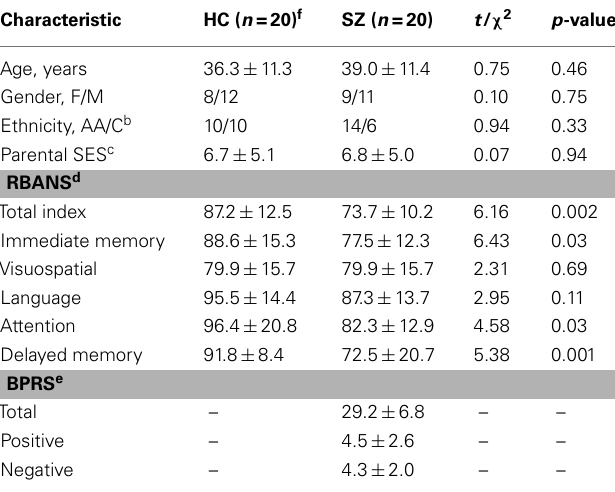
Table 1 | Demographics and clinical measures a .